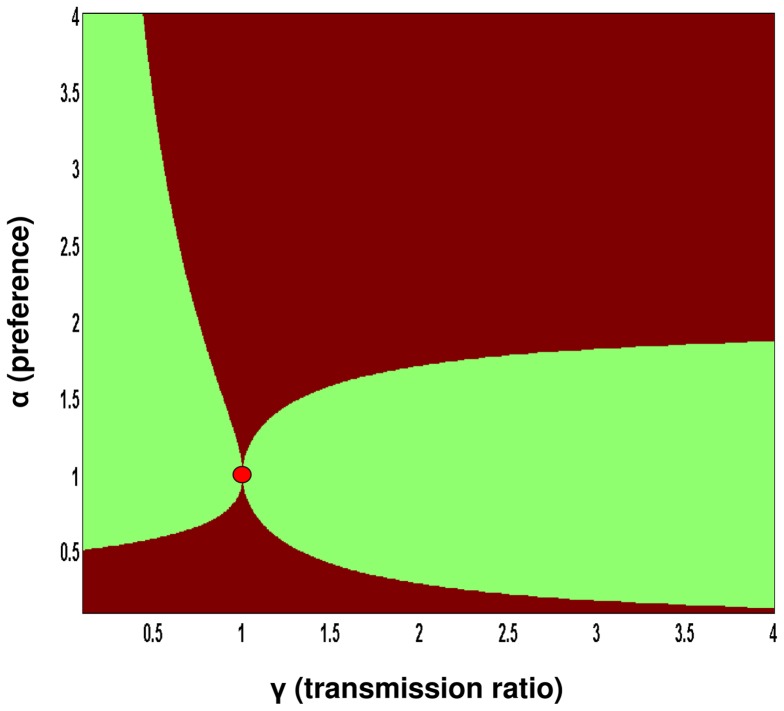
The qualitative behavior of R
0 as a function of the model parameters.The qualitative way by which R
0 depends on the values of the vector preference α, and the host transmission ratio, γ. Brown: R
0 is hump-shaped (diversity amplification), Green: R
0 is monotonic (dilution effect), Red: R
0 is constant (independent on species diversity). Note that R
0 is constant only at a single point where α = γ = 1, a case which is equivalent to a single host model. The red point is therefore disproportionally emphasized. It is apparent that diversity amplification is at least as common as the dilution effect in this parameter range. (i.e., 0.1≤γ≤4, 0.1≤ α ≤4).